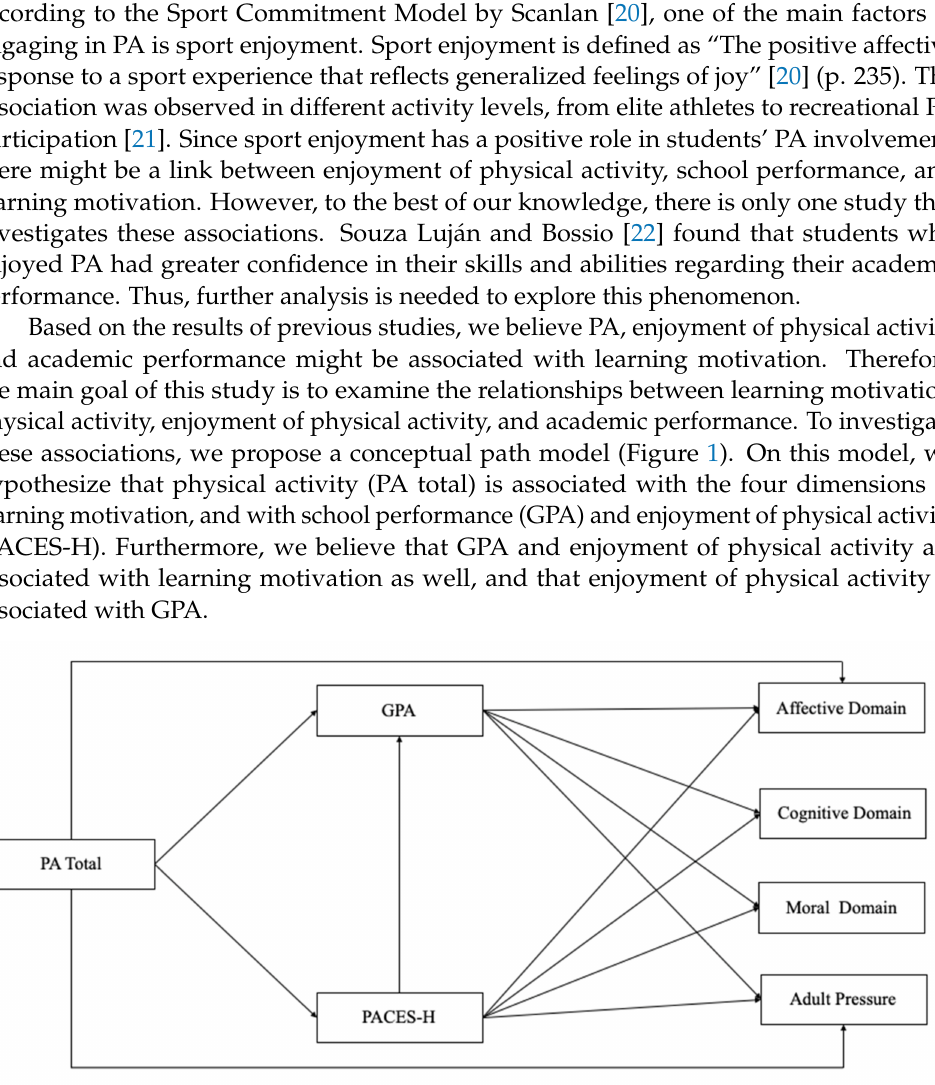
Figure 1. Hypothesized path model and its associations between PA, PACES-H, GPA, and the dimensions of learning motivation. note. PA = Physical Activity; PACES-H = Physical Activity Enjoyment Scale; GPA = Grade Point